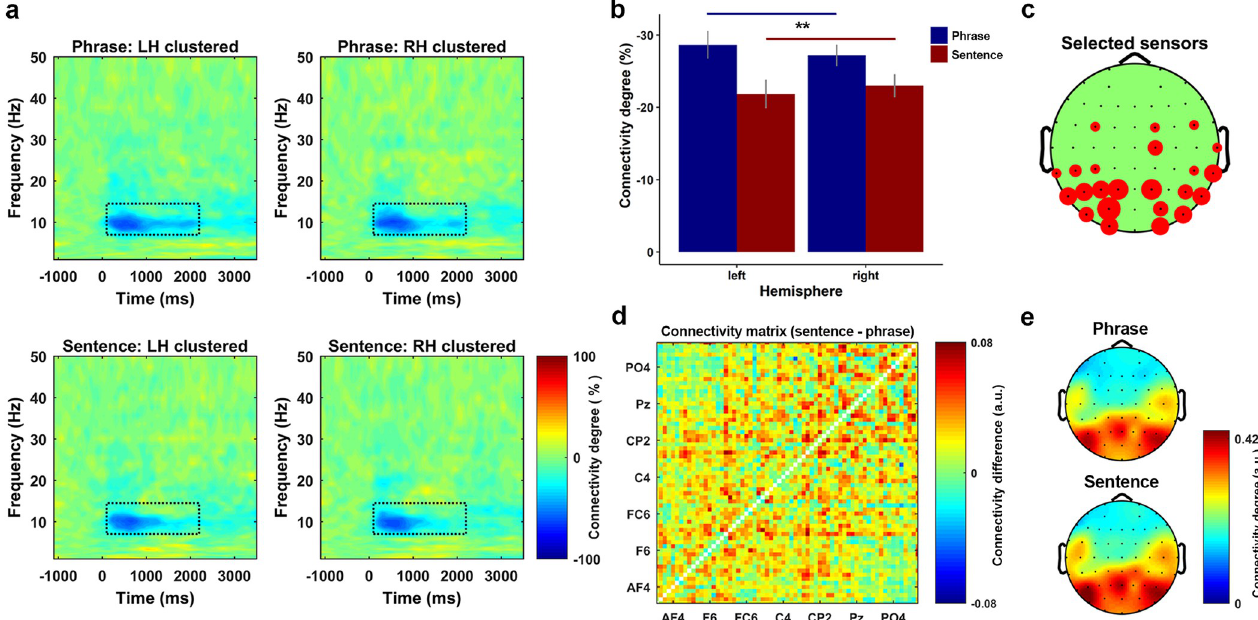
Fig 6. Power connectivity in the alpha band suggests a separation between phrases and sentences. (a) Power connectivity degree for all conditions. Each plot was clustered by the sensors at each hemisphere that showed the biggest inhibition on the grand averaged power connectivity. (b) The results of a two-way repeated measures ANOVA for the power connectivity on the factors of stimulus-type (phrase or sentence) and hemisphere (left or right). The results indicate a significant main effect of stimulus-type, post-hoc comparison on the main effect indicated that the overall inhibition level of the power connectivity was stronger for the phrases than the sentences (t (29) = 2.82, p = 0.0085 �� , two-sided). (c) How sensors were selected for the clustering. The size of the red circle indicates the more times the sensor was selected across participants. (d) The connectivity differences between the phrases and the sentences on all sensor pair. The figure was drawn using the average of the binarized connectivity matrix of the sentences minus the matrix of the phrases. The results indicate that the connectivity degree over the sensor space for the sentences was higher than the phrases. (e) Topographical representation of the binarized connectivity, which was clustered using the sensors showed biggest inhibition on the power connectivity. The upper and lower panel shows the phrase and sentence condition, respectively.